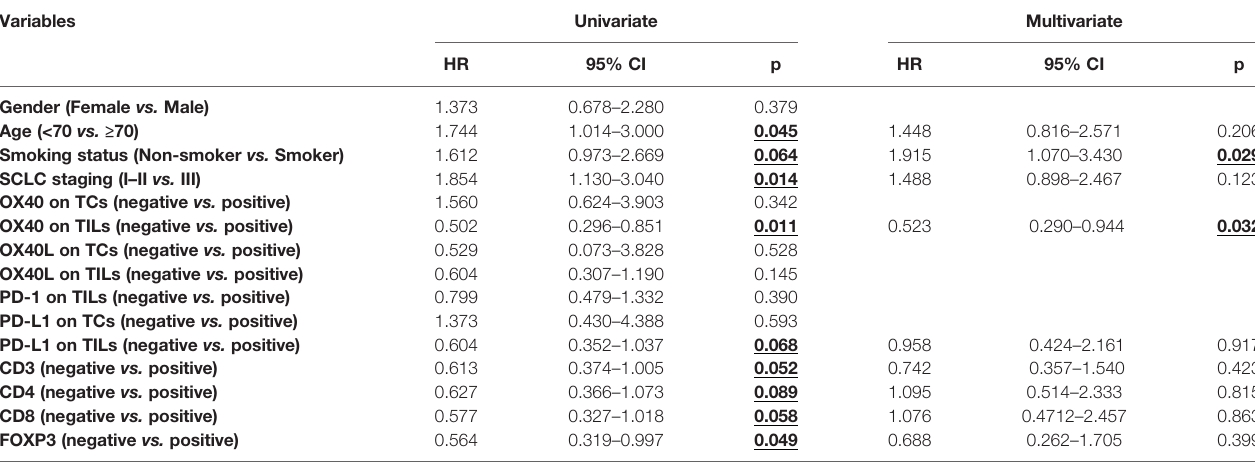
TABLE 2 | Cox regression analysis for recurrence-free survival in the whole IHC cohort*. Variables Univariate Multivariate HR 95% CI p HR 95% CI p Gender (Female vs.